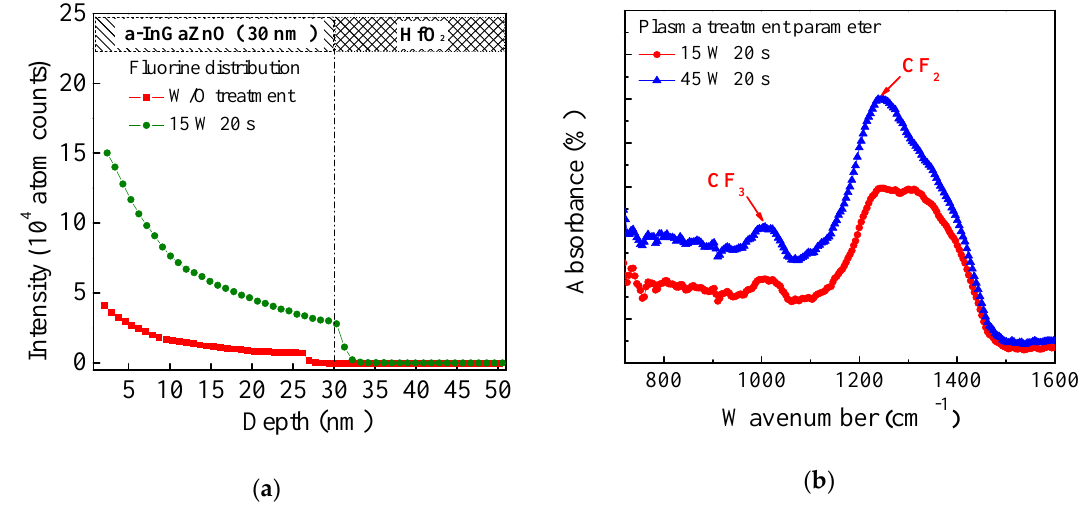
Figure 2. ( a ) SIMS depth profiles; ( b ) FTIR measurement for the untreated sample and the sample with the CF 4 plasma treatment after annealing at 250 °C for 60 min.